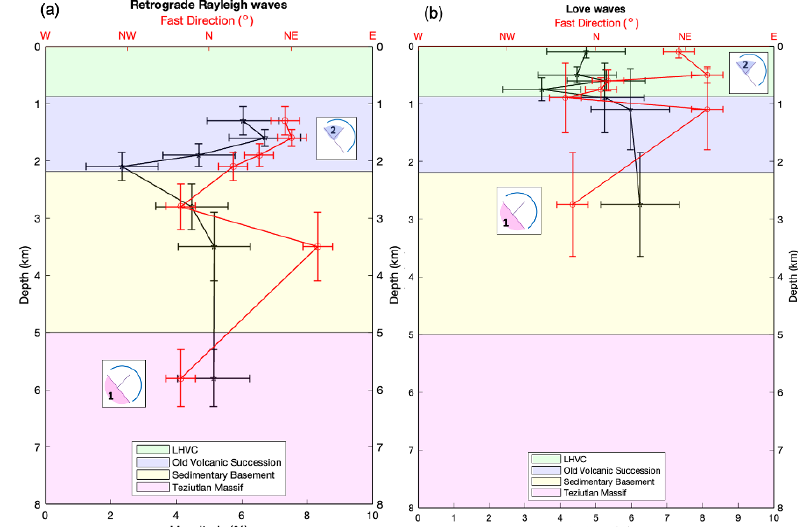
Figure 9. Fastest direction (red) and magnitude of apparent anisotropy (black) with depth for (a) retrograde Rayleigh and (b) Love waves; the results have been corrected with synthetic wavefield. The red and black bars depict the area of uncertainty and the shaded areas represent the average depth of the different lithologies using well data from various sources (Arellano et al., 2003; Carrasco-Núñez et al., 2017a, b; Cedillo-Rodríguez, 1997; Norini et al., 2019). The numbers 1 and 2 marked on the graph represent the zone orientation from Fig. 1 that matches the fast